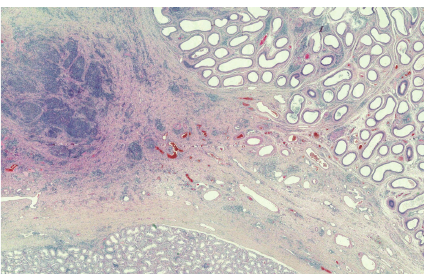
Figure 2: Testicular parenchyma in the bottom, epididymis in the upper right, and inflammatory vestigial remnants in upper left.